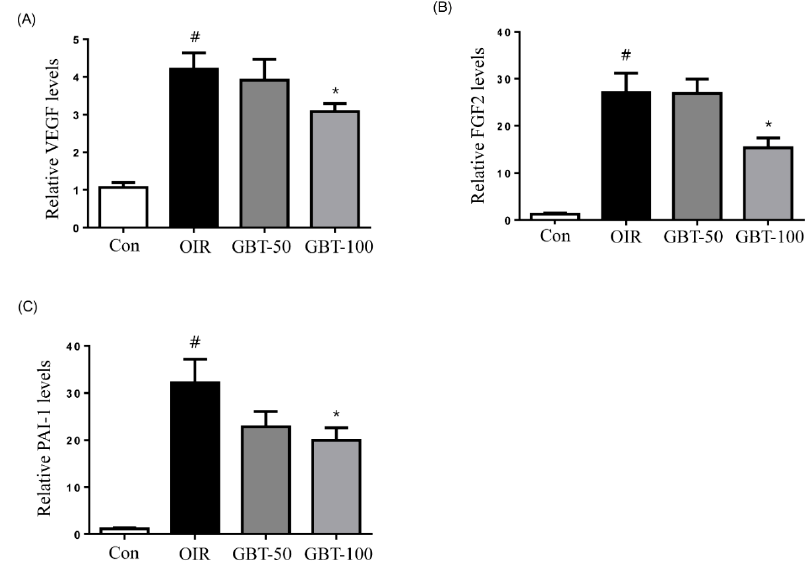
Figure 4. Real-time PCR analysis of VEGF, FGF2 and PAI-1 mRNA levels in OIR mice. When compared with normal controls, relative VEGF ( A ); FGF2 ( B ) and PAI-1 ( C ) mRNA expression levels were markedly increased in OIR mouse retinas and dramatically reduced after GBT treatment. Con, normal control mice; OIR, saline-treated OIR mice; GBT-50, OIR mice treated with GBT (50 mg/kg); and GBT-100, OIR mice treated with GBT (100 mg/kg). Data are represented as mean ± SE ( n = 4). # p < 0.0001 for control group vs. OIR group; * p < 0.05 for OIR group vs. GBT-treated group.